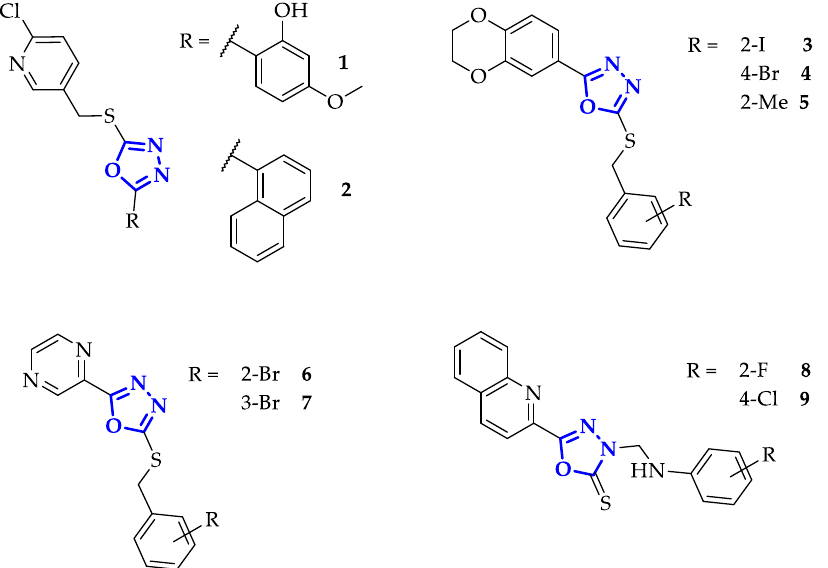
Figure 3. Chemical structures of 1,3,4-oxadiazole derivatives identified as good telomerase inhibitors.